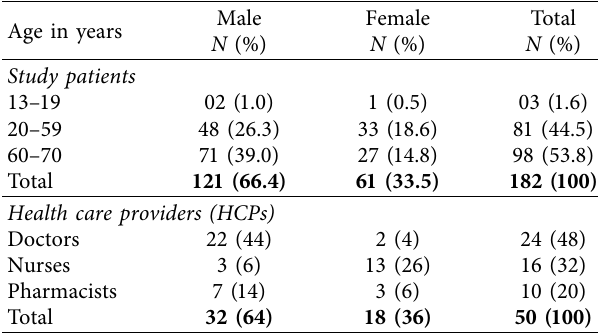
Table 1: Demographic details of the study patients and